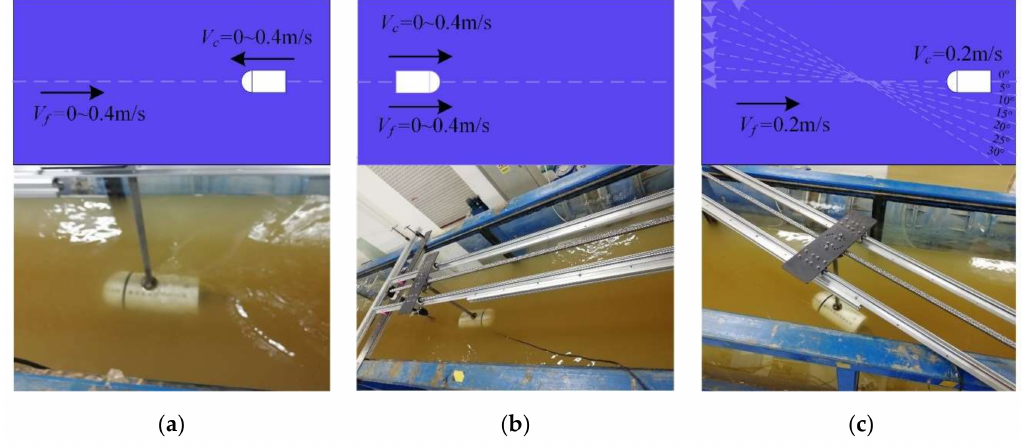
Figure 15. Experimental process. ( a ) Opposite direction; ( b ) Same direction; ( c ) Di ff erent